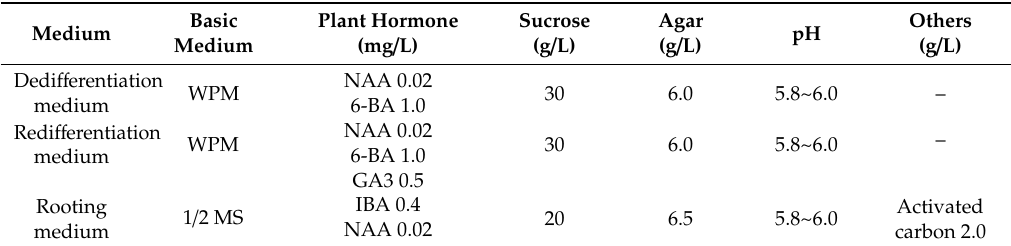
Table 1. Formula of tissue culture medium for B. platyphylla .